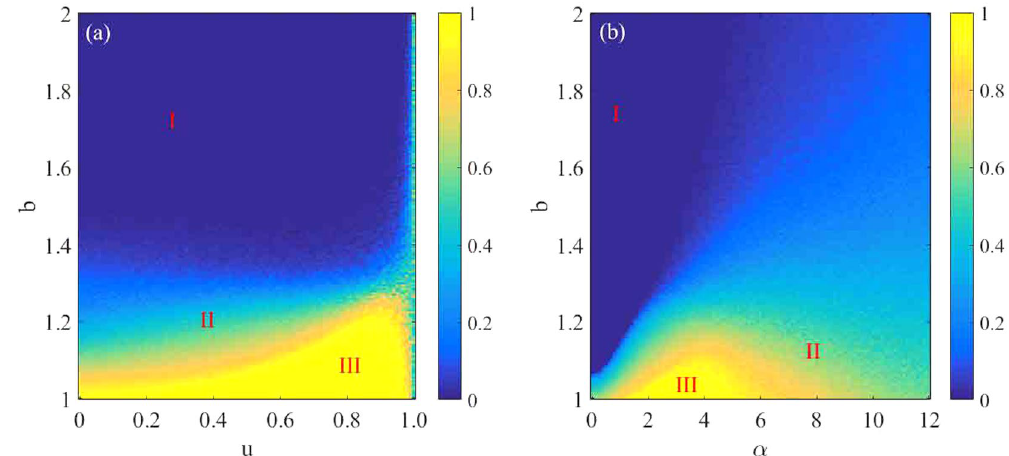
Figure 4. The color-coded (see bar on the right) fraction of cooperation ρ c on the b - u parameter plane and the b - α parameter plane. Panel (a) represents the b - u parameter plane for α = 3.0 and panel (b) shows the b - α parameter plane at u = 0.5. The simulation results suggest that in addition to u = 1.0, the fraction of cooperation is positively correlated with the value of u when the value of α is fixed. Panel (b) shows that when α is between 2.0 and 6.0, cooperation has been improved to the most